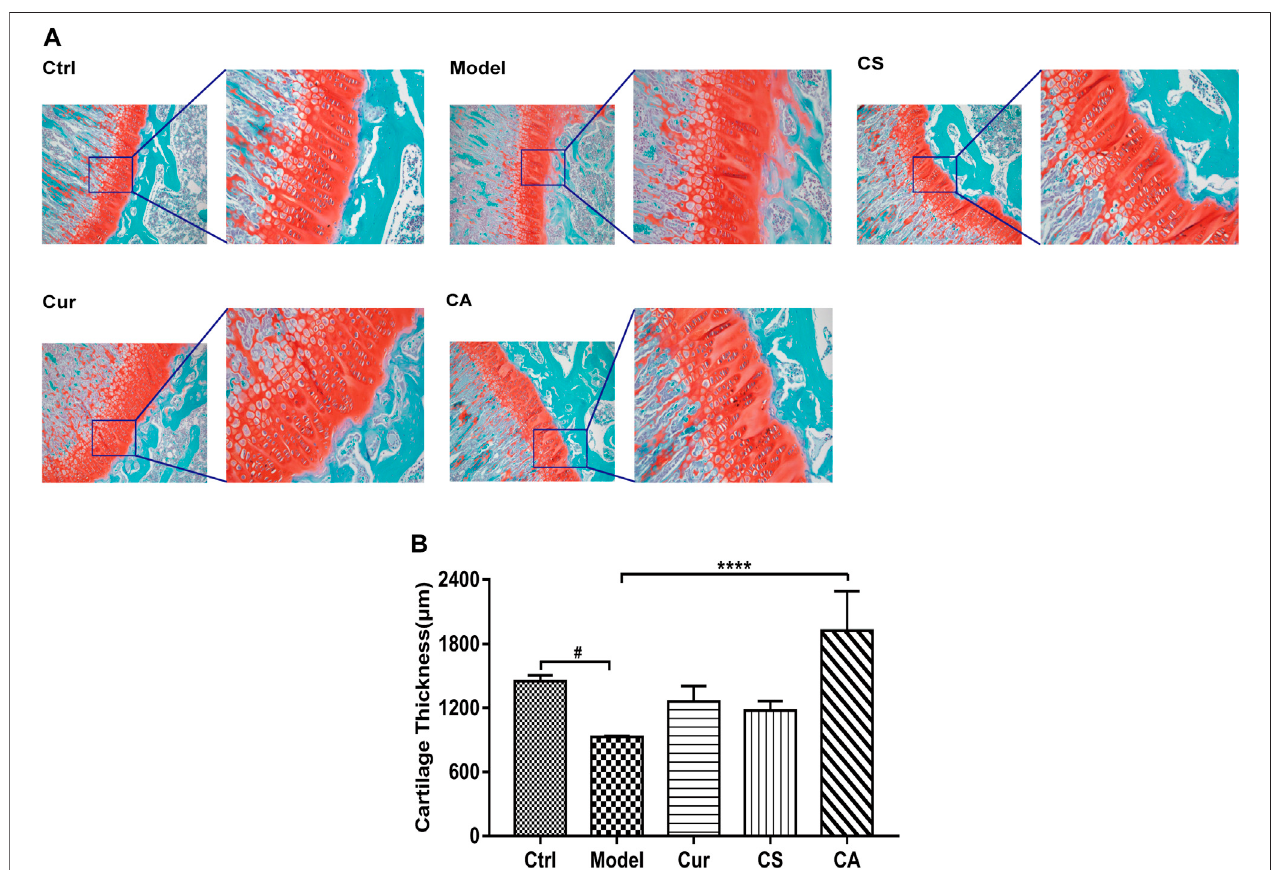
FIGURE3| Repair oftheinjured cartilagein each KOA group. (A) Safranin fastgreenstainingimage ofeach group. (B) Cartilagethickness ofeach group. Dataare presented as the mean ± SD ( n = 4). # p < 0.05, vs. Ctrl group; **** p < 0.0001 vs. model group. Scale bar = 100 μ m.